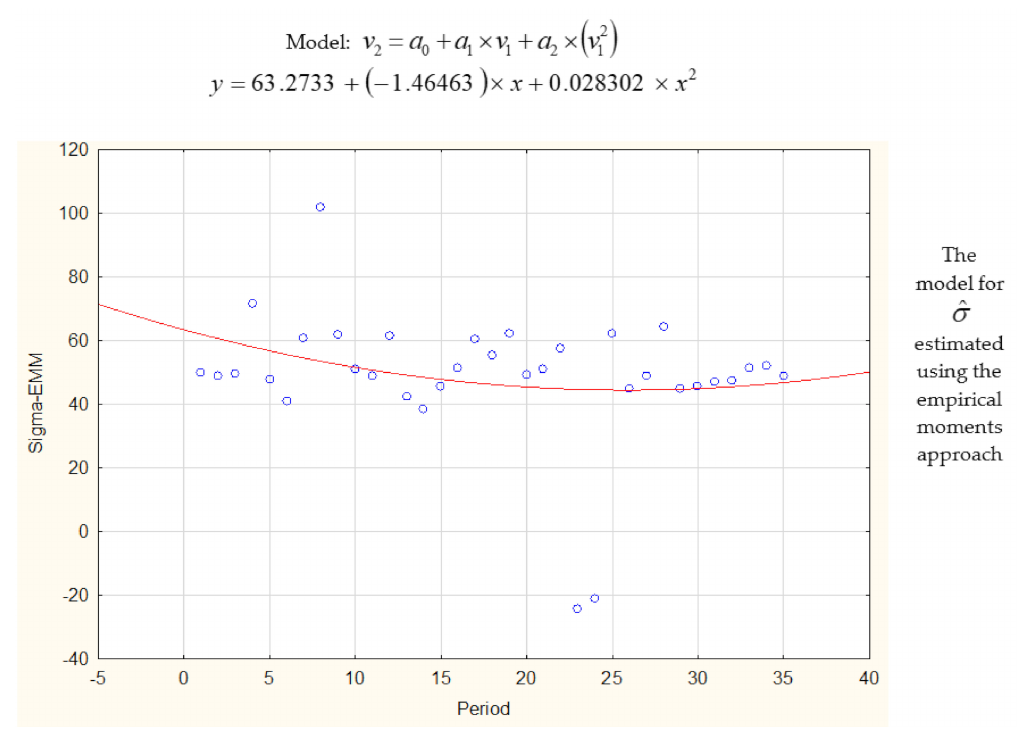
Figure 2. The models describing parameters ˆ σ , ˆ m achieved using the Gauss–Newton method and the fitted